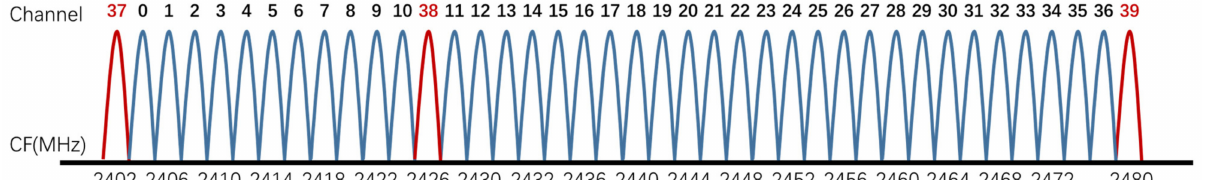
Figure 4. Bluetooth channel distribution.